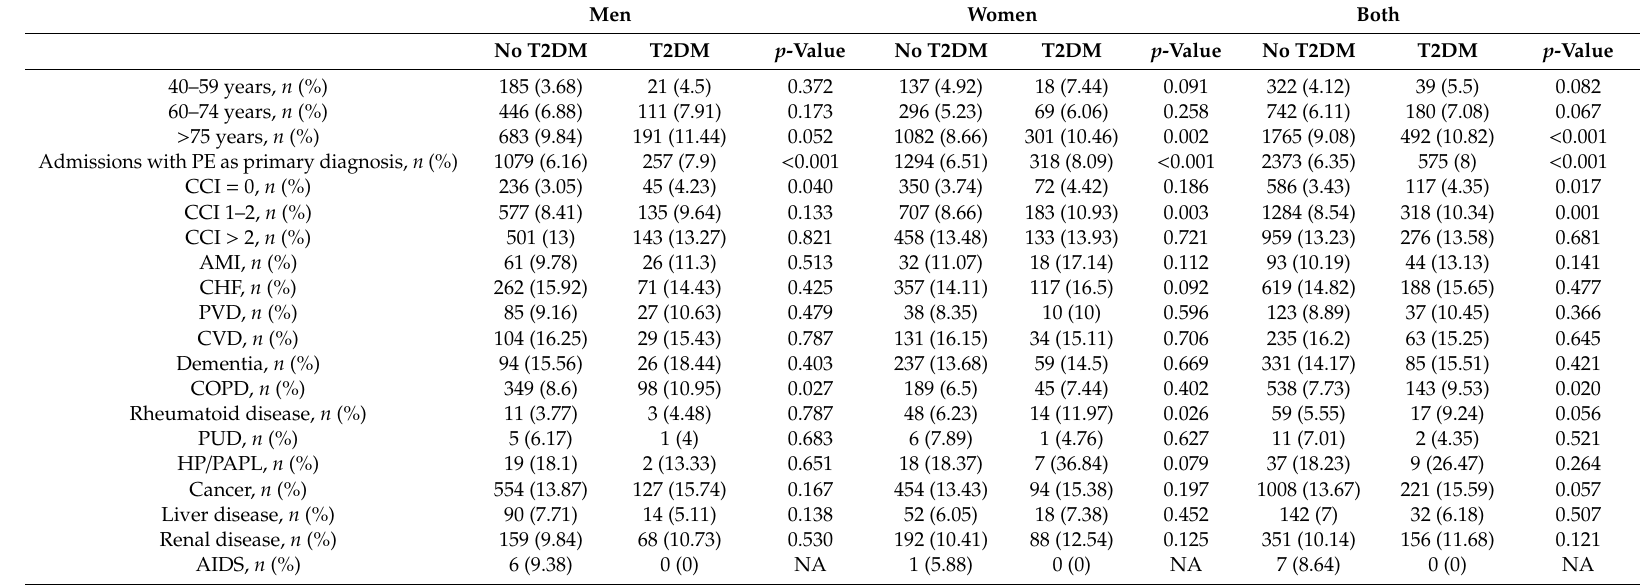
Table 3. In-hospital mortality according to clinical characteristics among men and women with and without type 2 diabetes (T2DM) hospitalized with pulmonary embolism in Spain